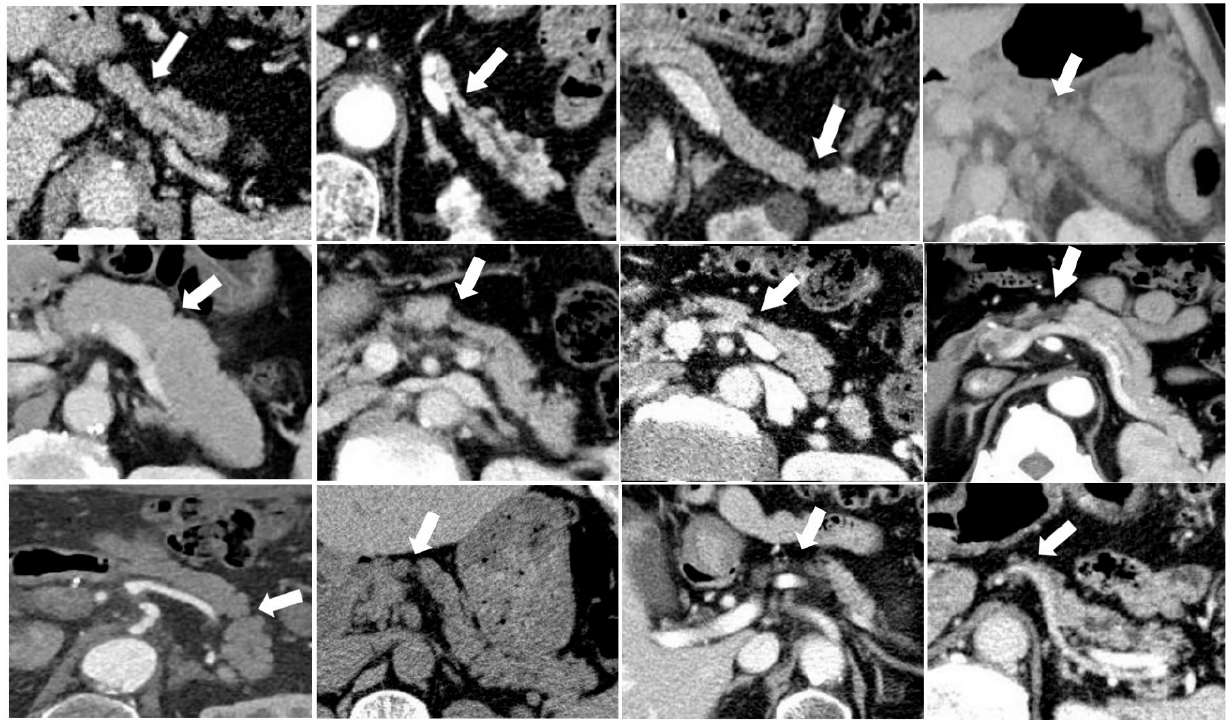
Figure 3. CT images of various types of focal parenchymal atrophy (white